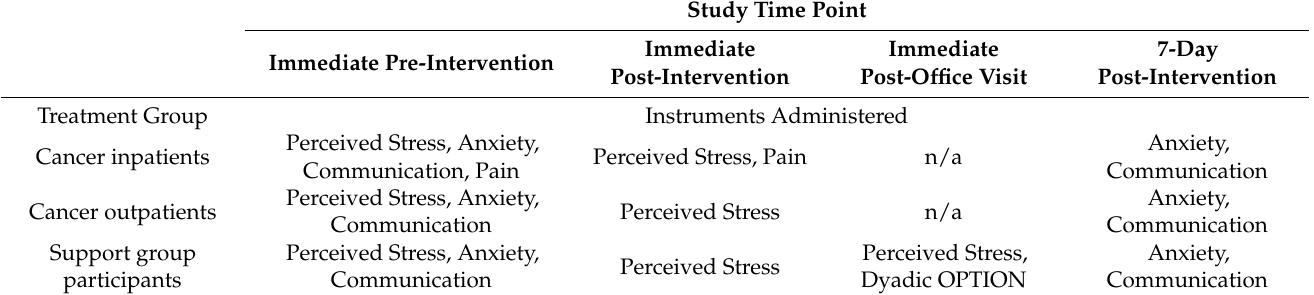
Table 1. Study questionnaires given by time point and treatment group.